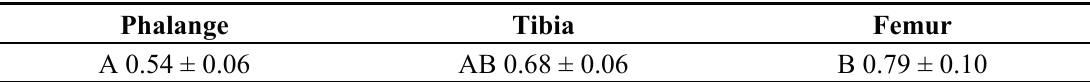
Table 3. Expression of the COL2A1 difference among bones (least squares means ± SE (standard error)). Least squares means associated with the same letter are not significantly different at an experiment-wise α = 0.05, by the Tukey–Kramer